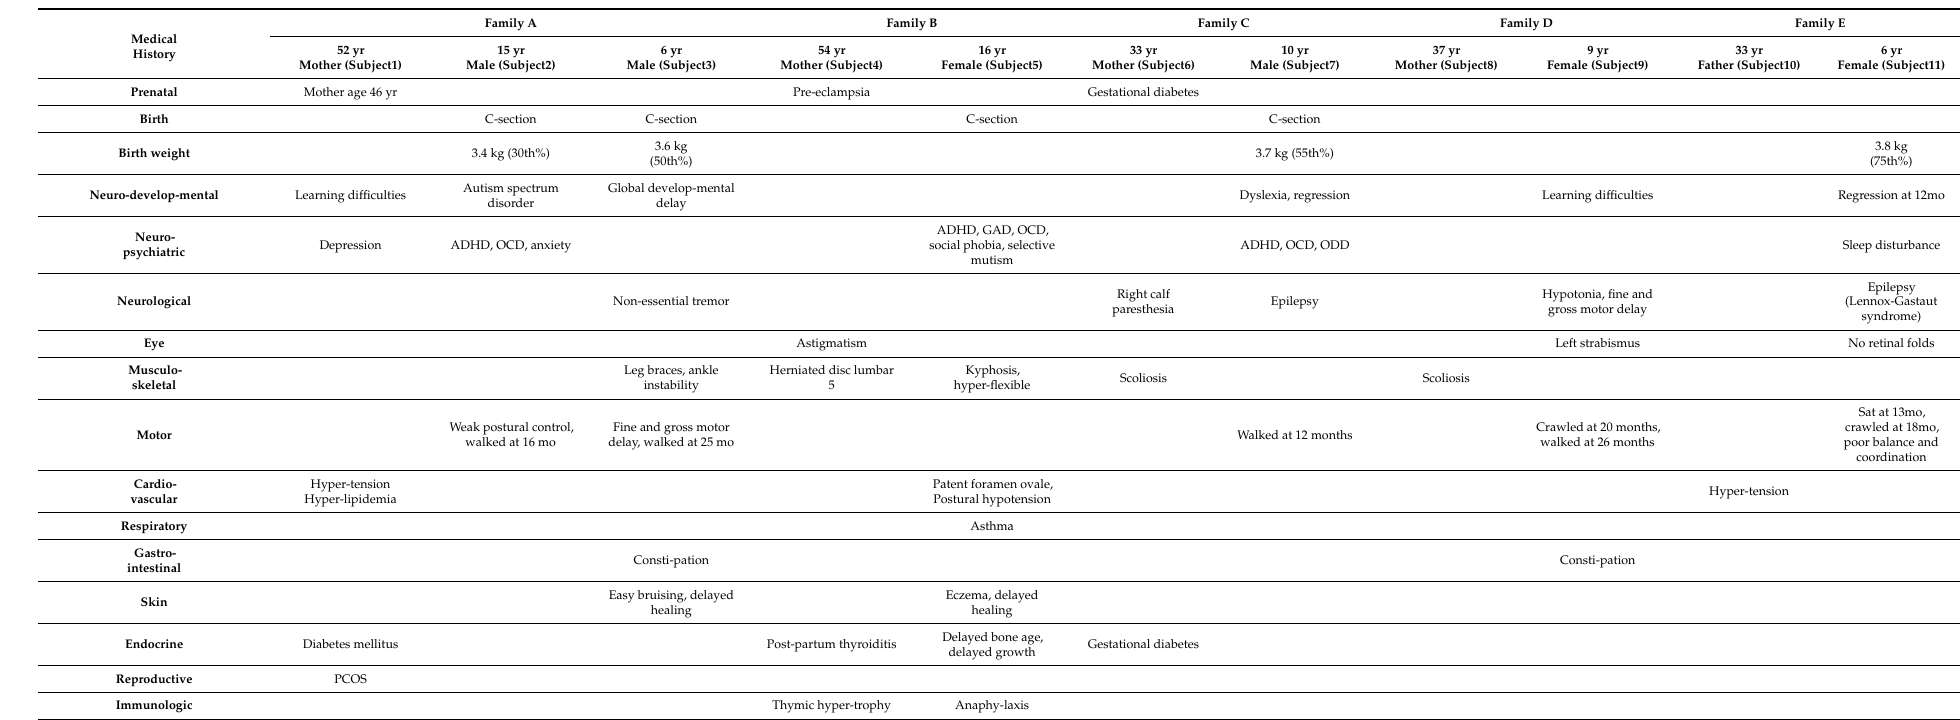
Table 4. Medical history of families with 15q11.2 BP1-BP2